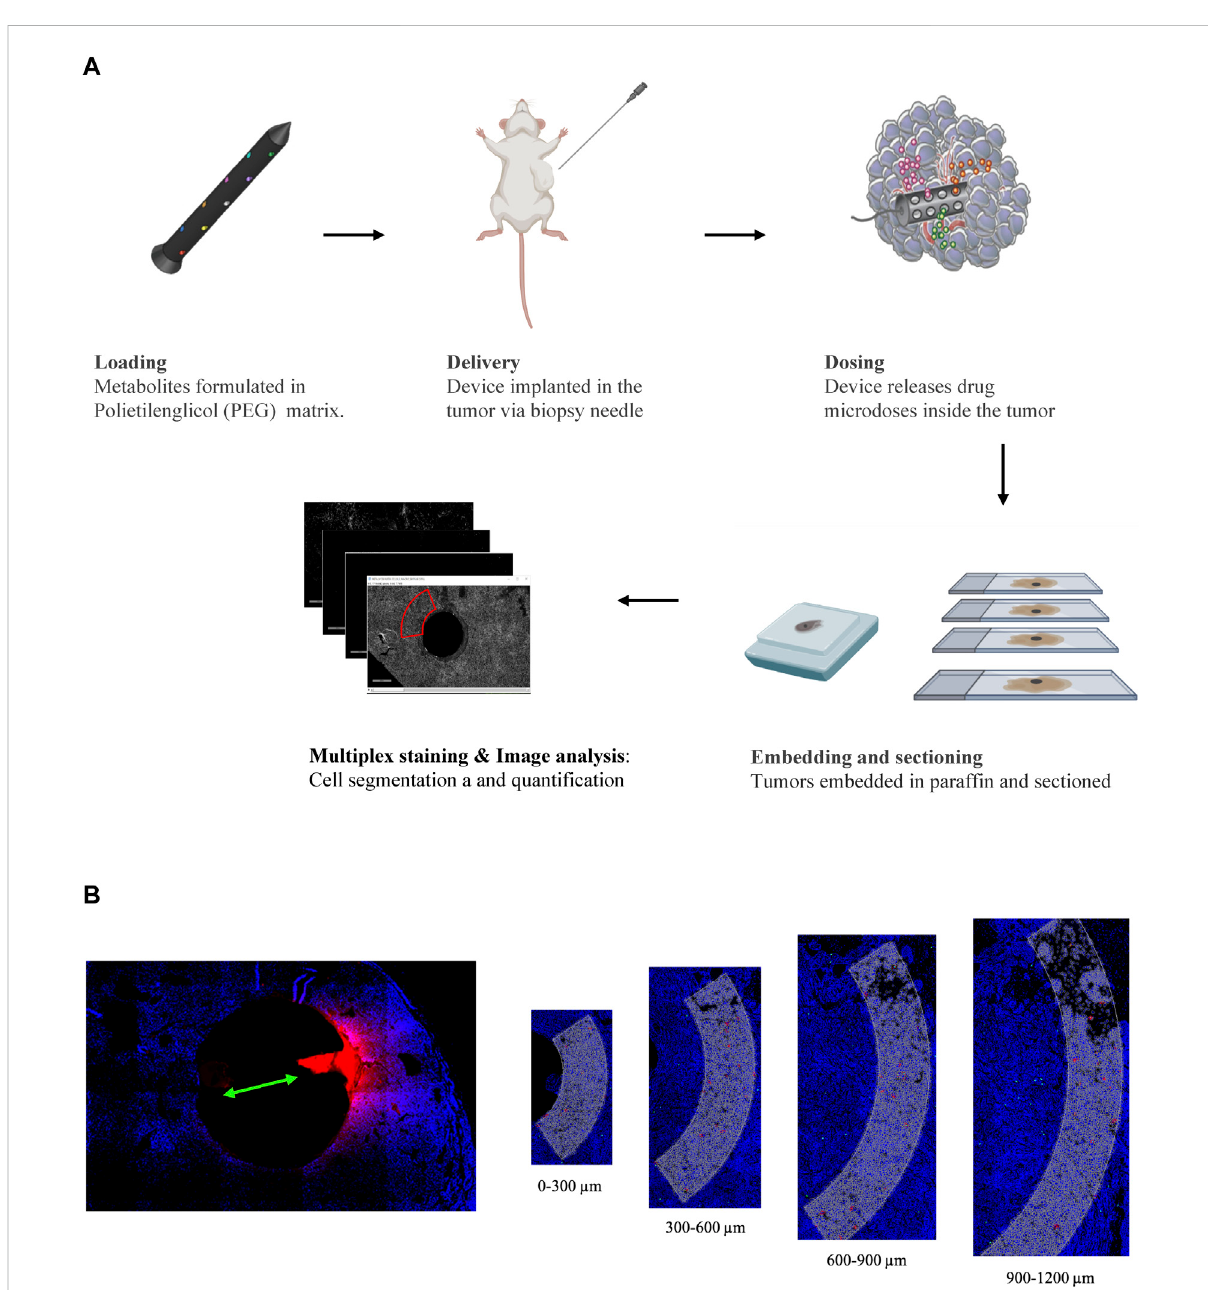
FIGURE 1 (A) Schematic representation of the experimental pipeline showing the different steps from IMD preparation to image analysis. (B)